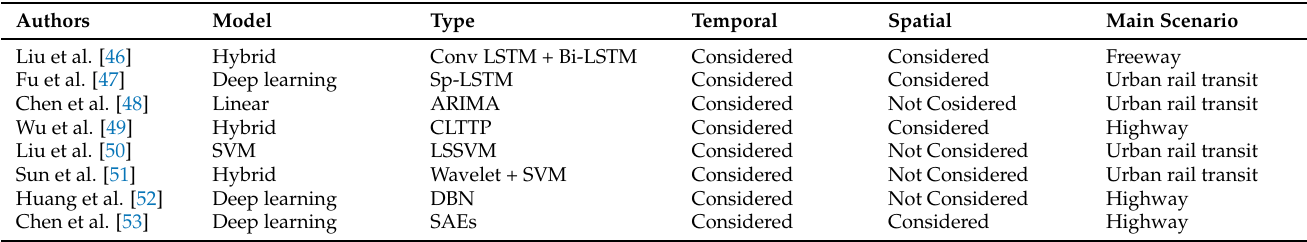
Table 1. Existing studies